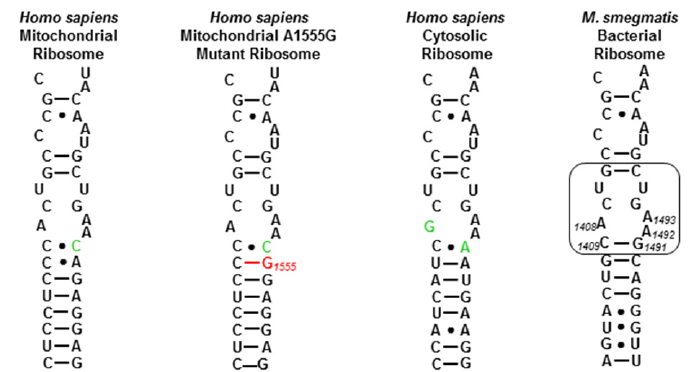
Figure 2. Decoding A sites of prokaryotic and eukaryotic ribosomes. The bacterial AGA binding pocket is boxed. The bacterial numbering scheme is illustrated for the AGA binding pocket. Changes from the bacterial ribosome binding pocket are colored green. The A1555G mutant conferring hypersusceptibility to AGA ototoxicity is colored red.